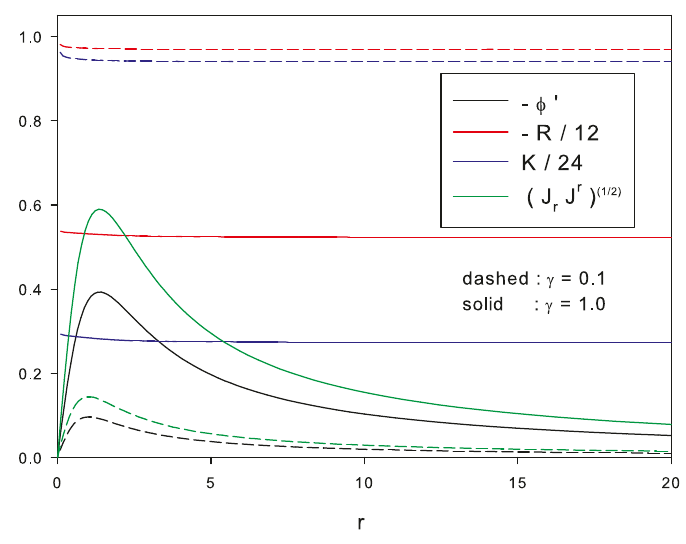
Figure 1 . We show the dependence of (cid:0) (cid:30) 0 , the Ricci scalar R , the Kretschmann scalar K = R (cid:23)(cid:22)(cid:26)(cid:27) R (cid:23)(cid:22)(cid:26)(cid:27) and the norm of the Noether current ( J r J r ) 1 = 2 on the radial coordinate r for soliton solutions with (cid:3) = (cid:0) 3 and (cid:13) = 0 : 1 (dashed) and (cid:13) = 1 : 0 (solid),